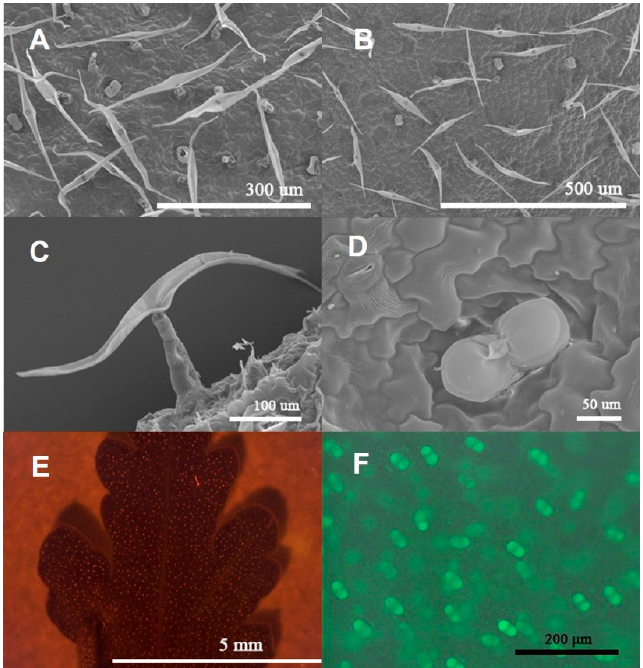
Figure 1. Scanning electron microscopy images of surfaces on mature Chrysanthemum leaves ( A – F ). Abaxial leaf of ‘ZJSYJ’ ( A ); adaxial leaf of ‘CJ’ ( B ); T-shape trichomes on the ‘HBJ’ leaf ( C ); glandular trichome on the ‘ZJSYJ’ leaf ( D ); distribution of glandular trichomes on the ‘NJYJ’ leaves under fluorescence microscopy ( E , F ).